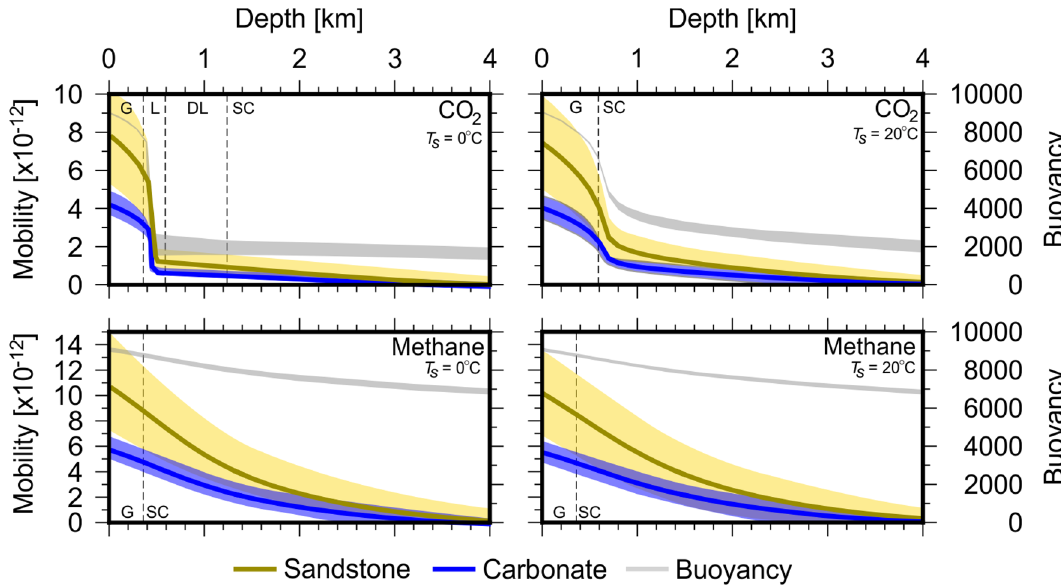
Figure 2. Fluid mobility for CO 2 and methane calculated according to Eq. (1). Fluid mobilities are calculated at T s = 0 ◦ C (left column) and T s = 20 ◦ C’. (right column), respectively. Units for fluid mobility are m 2 2 and buoyancy are kg m − S − . Yellow and blue lines represent fluid mobility in sandstone and carbonate, respectively. Grey lines represent buoyancy and shaded regions represent range of values calculated using different EoS and lithological parameters for Eq. (14). Dashed lines represent phase transitions: G gas, L liquid, DL dense liquid and SC